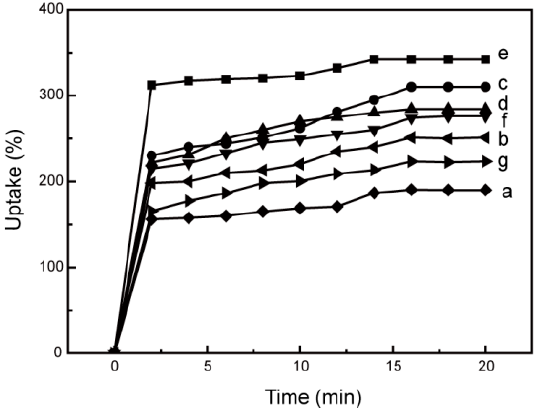
Figure 5. The uptake behavior of the membranes with different content of MgO: ( a ) 0 wt %; ( b ) 1 wt %; ( c ) 3 wt %; ( d ) 5 wt %; ( e ) 7 wt %; ( f ) 10 wt %; and ( g ) 15 wt %. ( c ) 3 wt %; ( d ) 5 wt %; ( e ) 7 wt %; ( f ) 10 wt %; and ( g ) 15 wt